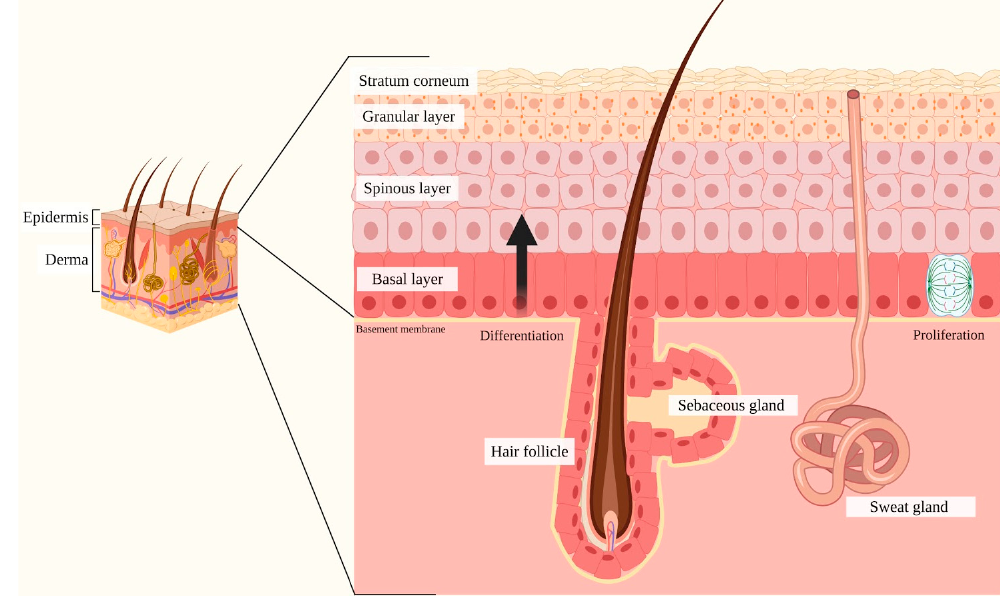
Figure 3. Schematic representation of the skin. The skin is composed of two layers: the epidermis and the dermis. The epidermis, the uppermost partition, is defined as a stratified squamous epithelium comprising the interfollicular epidermis (IFE) and various skin appendages (hair follicles, sebaceous glands and sweat glands). The IFE is primarily composed of progressively di ff erentiated keratinocytes organized in specific layers, which include the basal layer (the deepest portion of the epidermis), stratum spinosum, stratum granulosum and stratum corneum (the most superficial portion of the epidermis). The basal layer comprises mitotically active cells that generate during every cell division process, either stem cells that self-renew or transient amplifying cells that gradually undergo terminal di ff erentiation by migrating upwards towards the stratum corneum. This process requires specific signals released by the various skin appendages and contemplates the acquisition of layer-specific characteristics by keratinocytes, including the expression of epidermal keratins and transcriptional activators. Once in the stratum corneum, keratinocytes are completely keratinized, metabolically inactive and are released through desquamation. The epidermis is physically and functionally separated from the surrounding dermis by the basement membrane. The dermis is a connective tissue layer interposed between the epidermis and the subcutaneous tissue, involved in the protection and support of the skin and the deeper layers, in aiding sensation and in assisting thermoregulation.